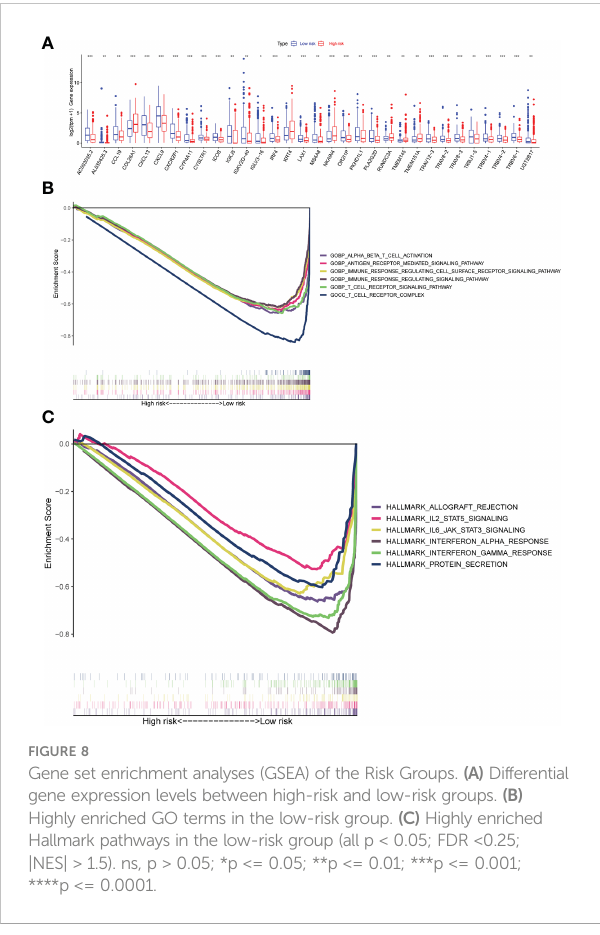
FIGURE 8 Gene set enrichment analyses (GSEA) of the Risk Groups. (A) Differential gene expression levels between high-risk and low-risk groups. (B) Highly enriched GO terms in the low-risk group. (C) Highly enriched Hallmark pathways in the low-risk group (all p < 0.05; FDR <0.25; |NES| > 1.5). ns, p > 0.05; *p <= 0.05; **p <= 0.01; ***p <= 0.001; ****p <= 0.0001.